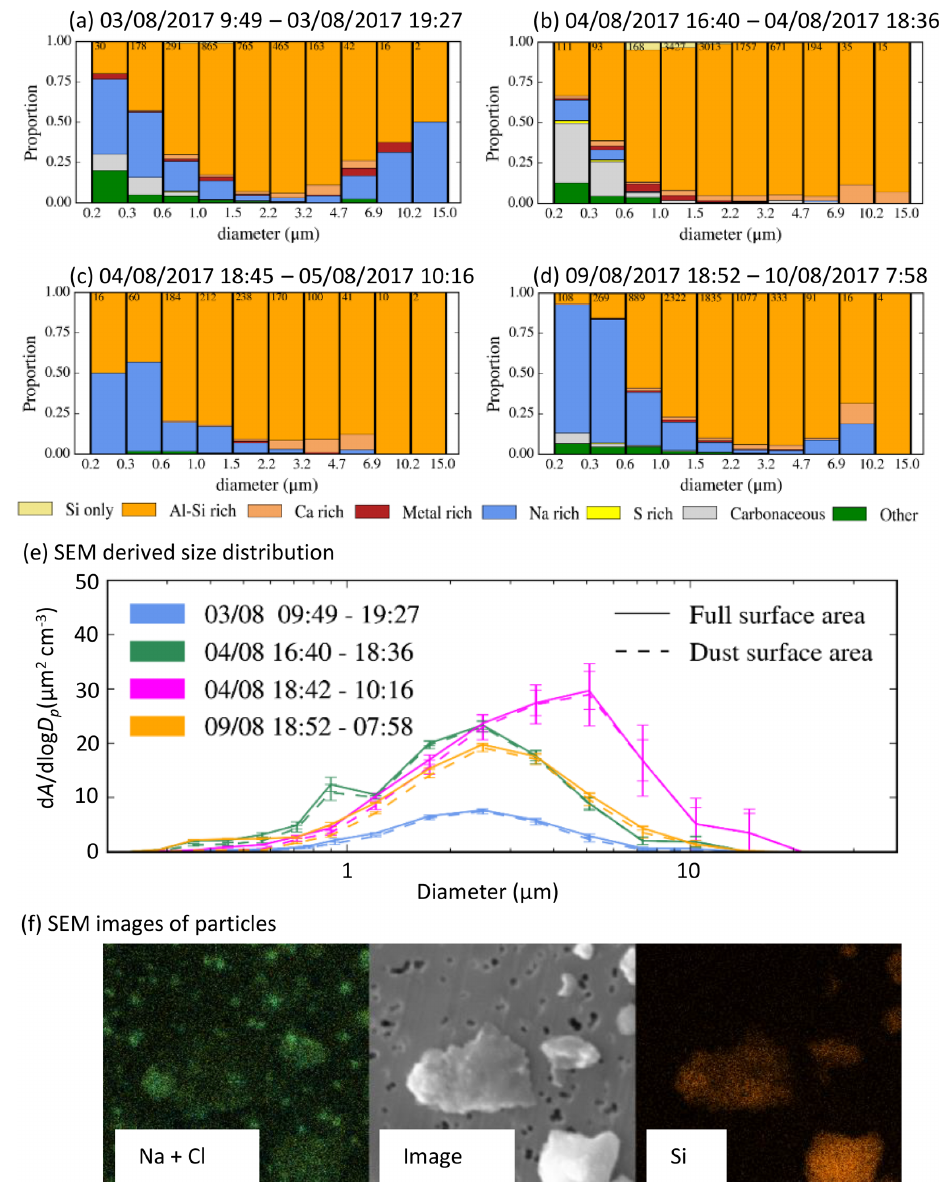
Figure 3. Scanning electron microscope (SEM) analysis of the composition of particles collected during the campaign. Panels (a) to (d) show the size-resolved composition of the particles with number of particles per bin indicated; panel (e) shows the surface area size distribution of all particles (solid lines) and the mineral dust category (Si, Al–Si-rich and Ca-rich; dashed lines); and panel (f) shows an example of several mineral dust grains in an electron microscope image (centre), the presence of Si in these (right) and particles rich in Na and Cl (i.e. fresh sea salt; left). Each image is approximately 25µm